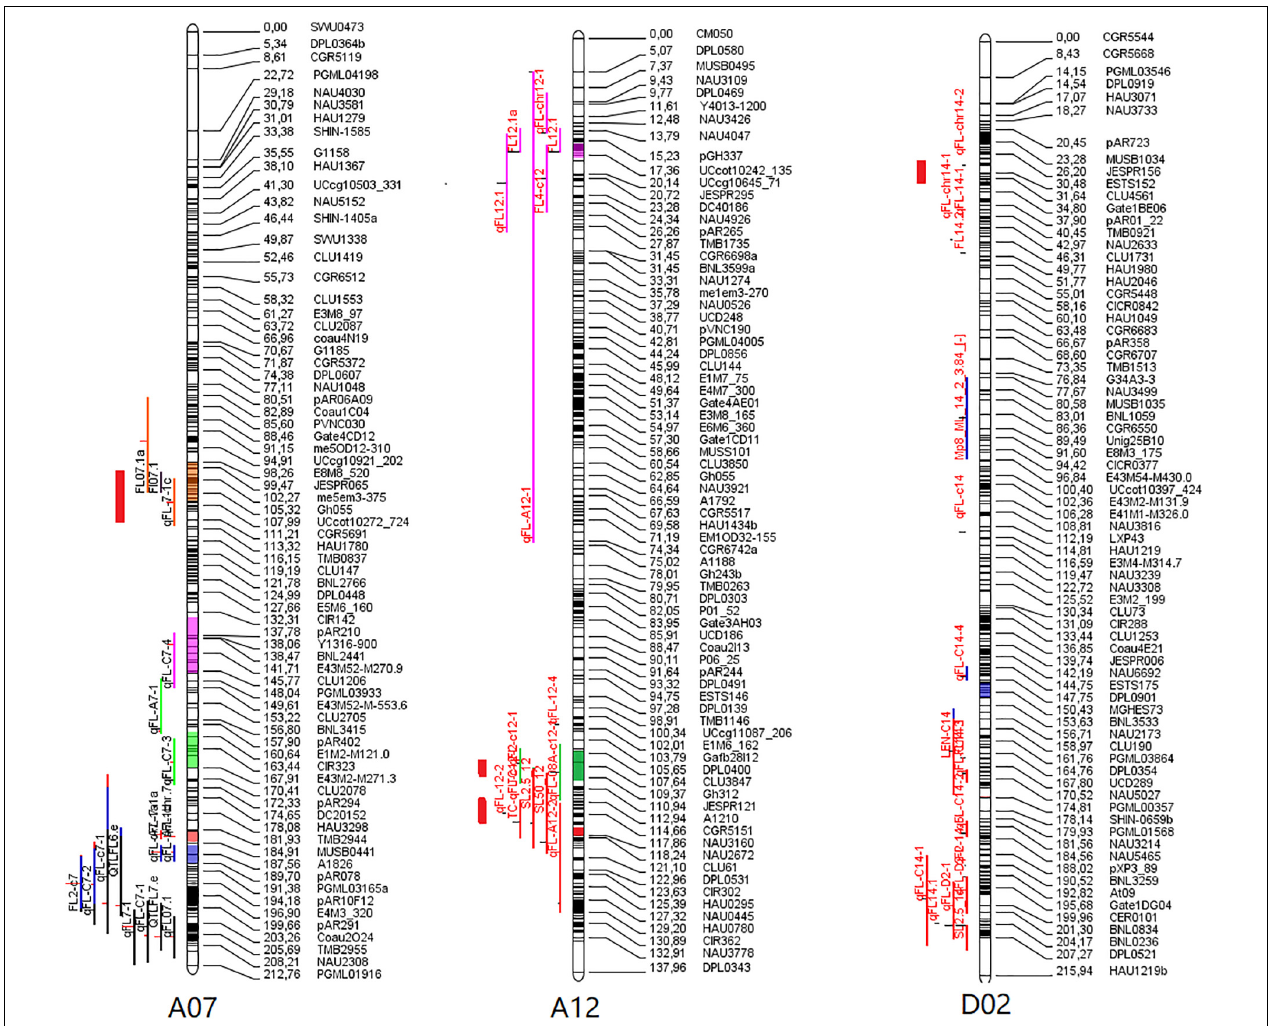
FIGURE 3 | Meta-analysis of QTLs associated with fiber length on chromosomes 7, 12, and 14. The thick red lines represent the four major QTL in this study.